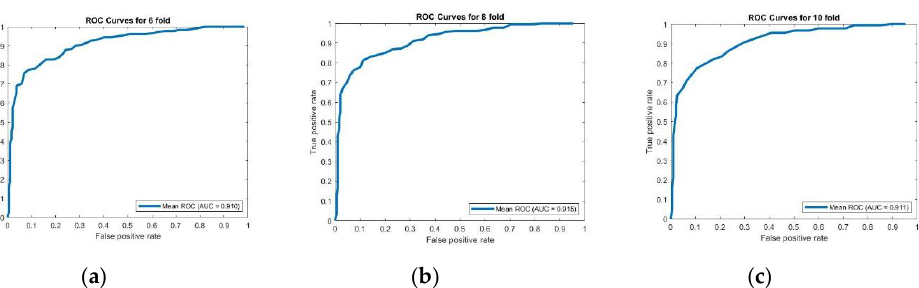
To give more insight of the performance of PupStruct, we generated ROC curve to measure AUC (area under the curve) and calculated the average AUC values for 6-, 8-, and 10-fold cross validations which was recorded at 0.910, 0.915 and 0.911 respectively which indicates stable performance of PupStruct. The results of the ROC-AUC analysis are shown in Figure 4.